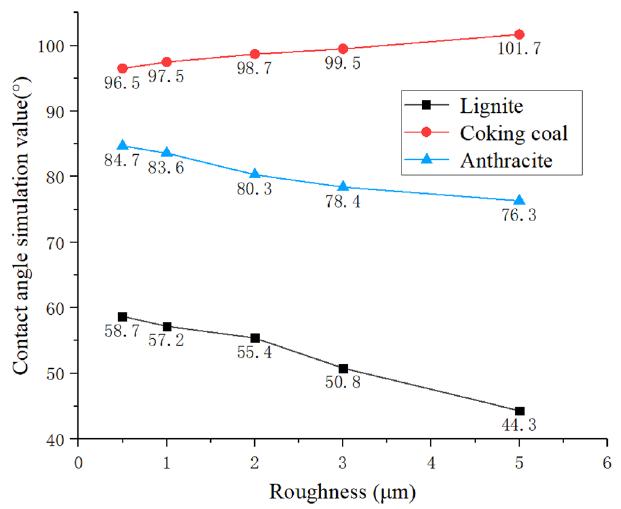
Figure 11. Simulated contact angles with different roughness of the three coal samples.